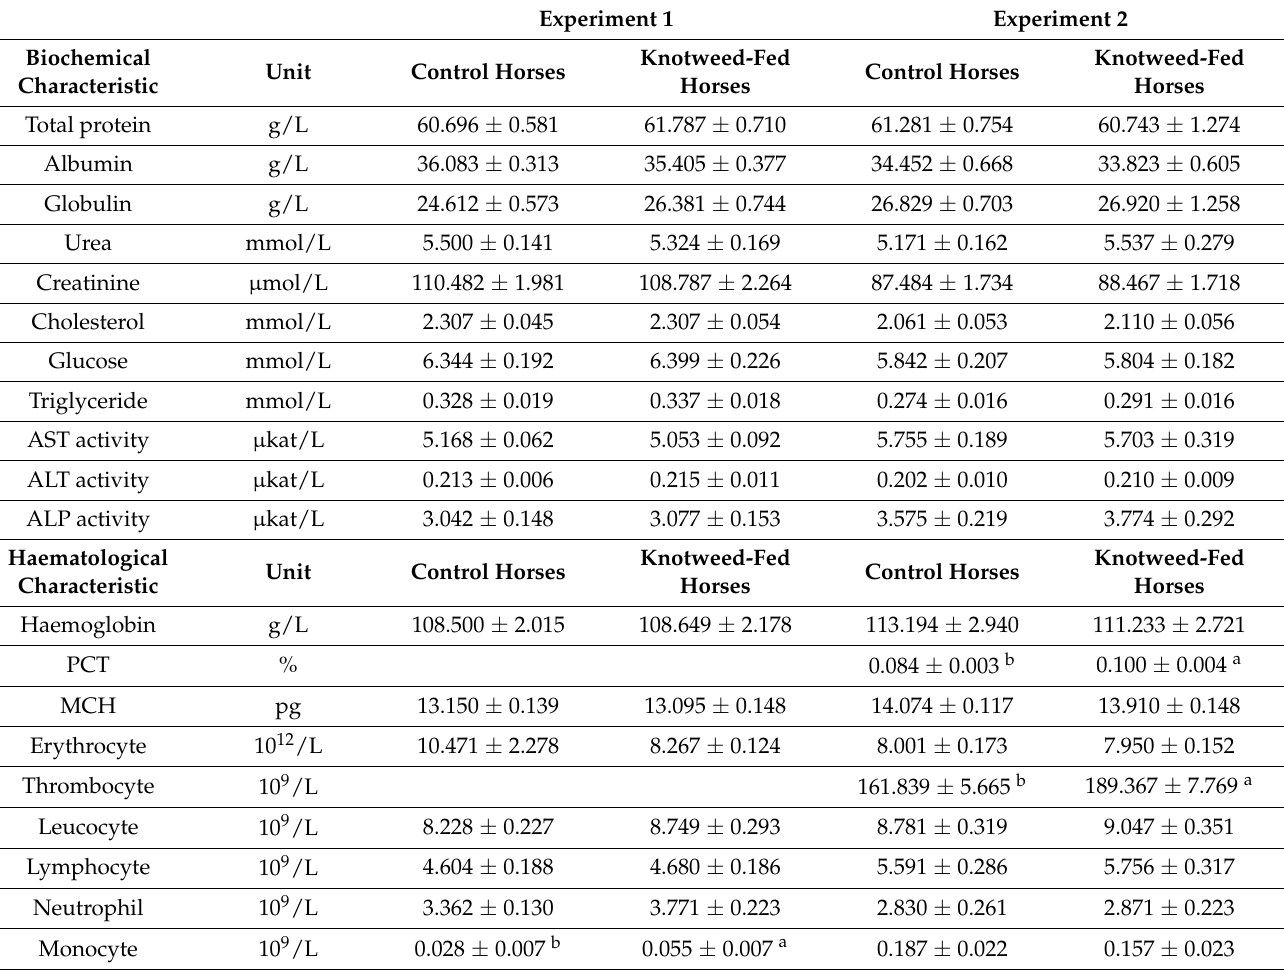
Table 2. Biochemical and haematological characteristics of horse blood from the end of Experiment 1 and of Experiment 2. Mean ± SEM. Significant differences between control and knotweed-fed horses are marked by different letters in